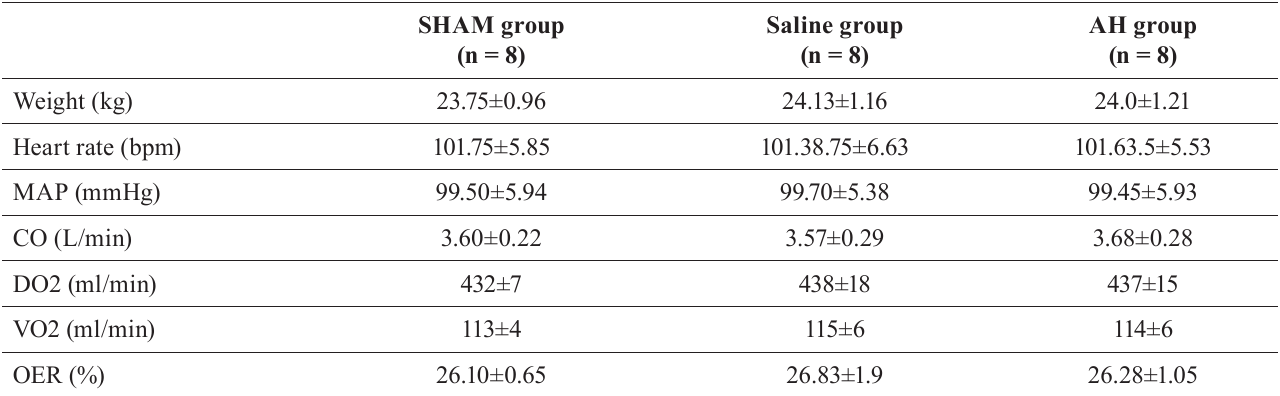
TABLE I - C haracteristics of minipigs in three groups